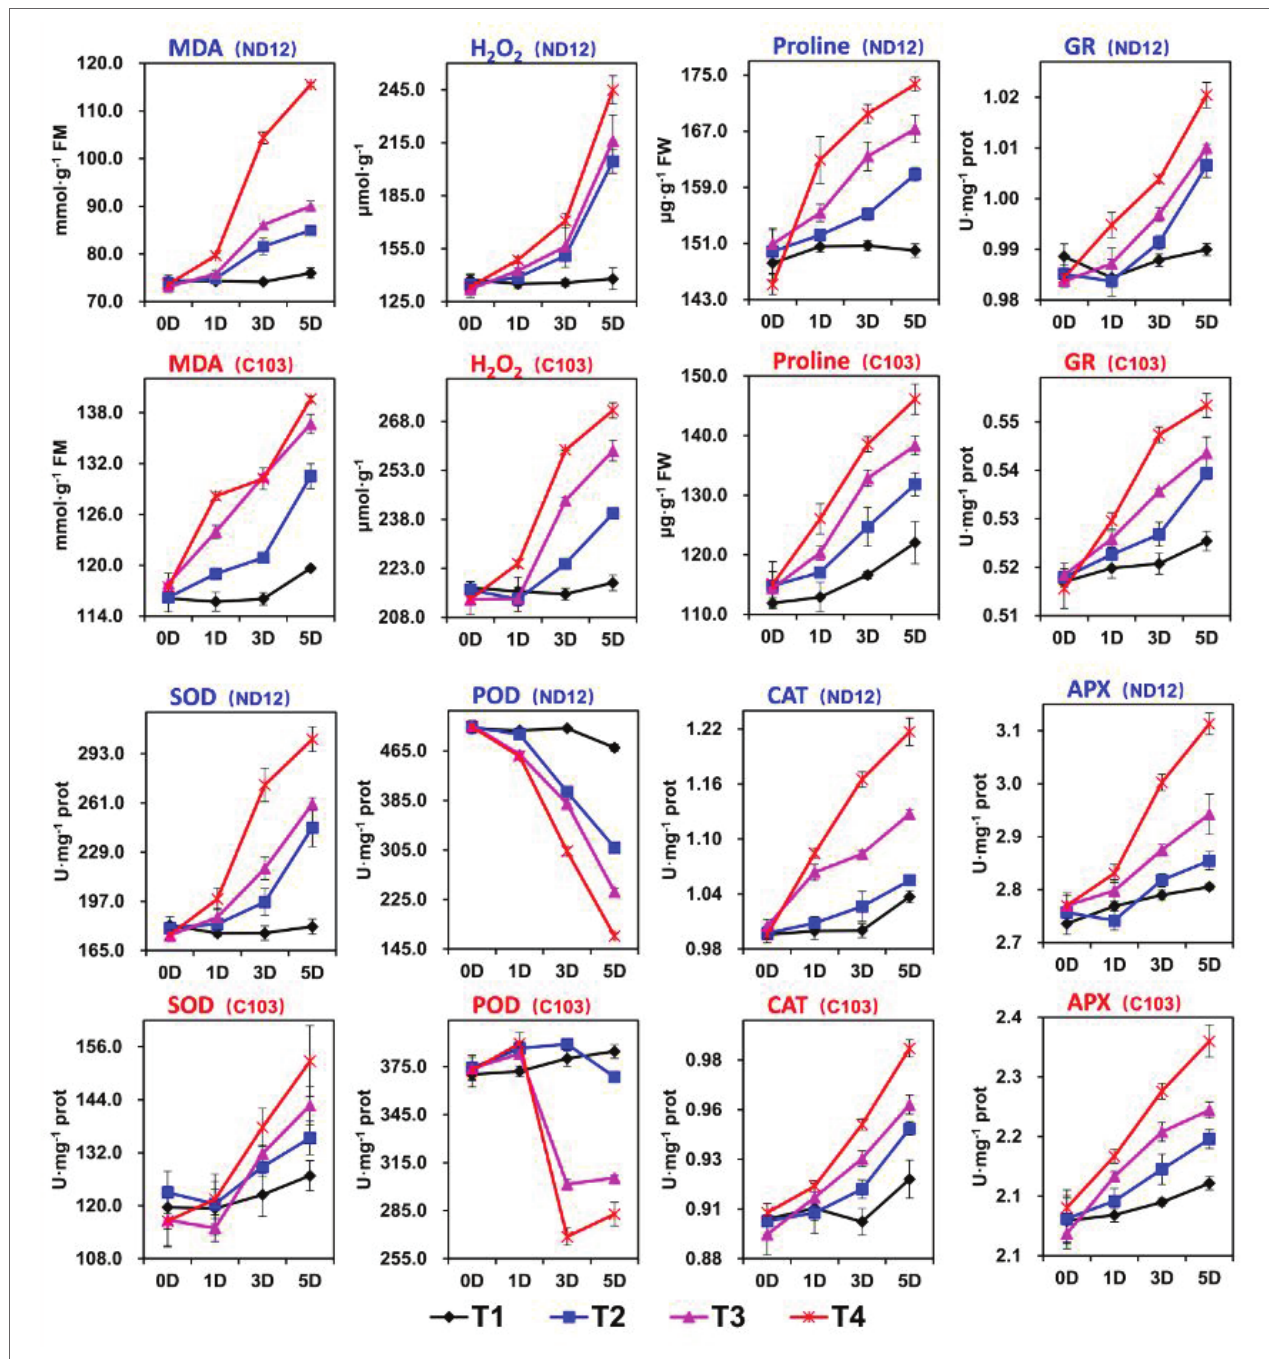
FIGURE 2 | Effect of different split-root PEG treatments on reactive oxygen species, enzymatic activity and proline of two soybean cultivars, ND-12 (drought- resistant) and C-103 (drought-susceptible). (Mean ± SE). T1 (0%: 0%), T2 (2%A: 0%B), T3 (6%A: 0%B), and T4 (4%A: